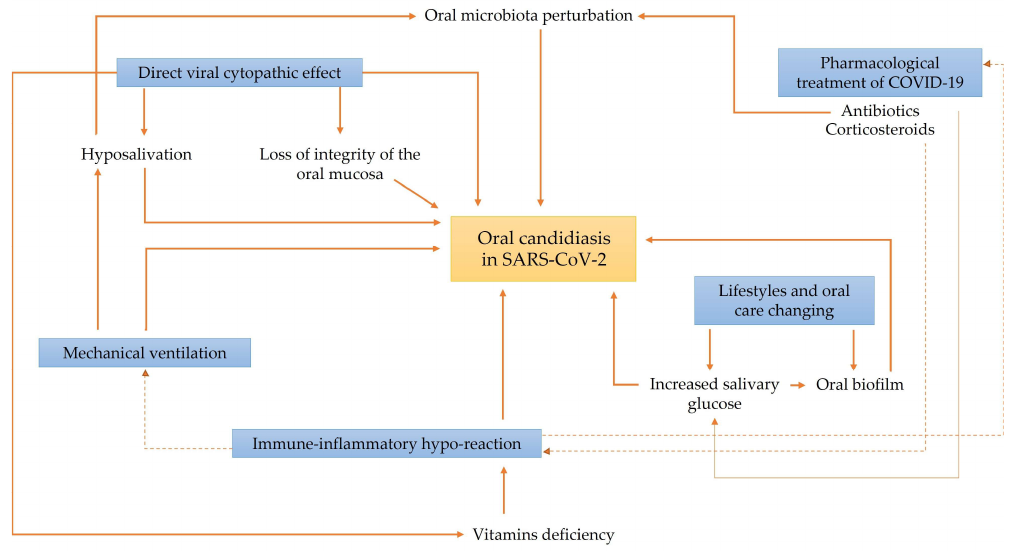
Figure 1. The risk factors in COVID-19 subjects favoring the onset of oral